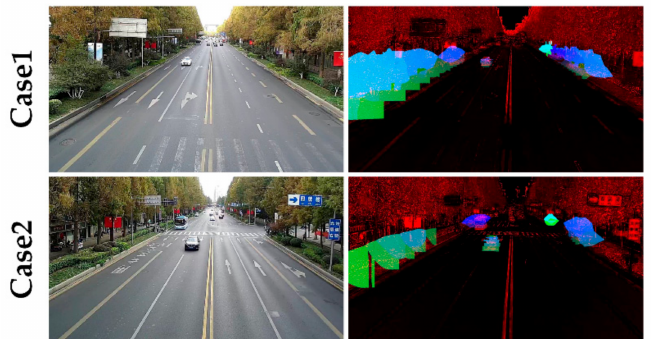
Figure 5. Two cases of the inputs of the Image subnet (the left column) and the LiDAR subnet (the right column). Case 1 shows a small-scale white car. Case 2 exhibits a light-blue bus and a medium-scale black car. From the visualizations of the LiDAR subnet input, the accurate distance and height value significantly contributes to the recognition of vehicles at semantic levels. However, the LiDAR-image also introduces inevitable noises into low-level cues, such as the edges. Therefore, it is acceptable that fusion from the semantic levels is more useful than fusion from the beginning